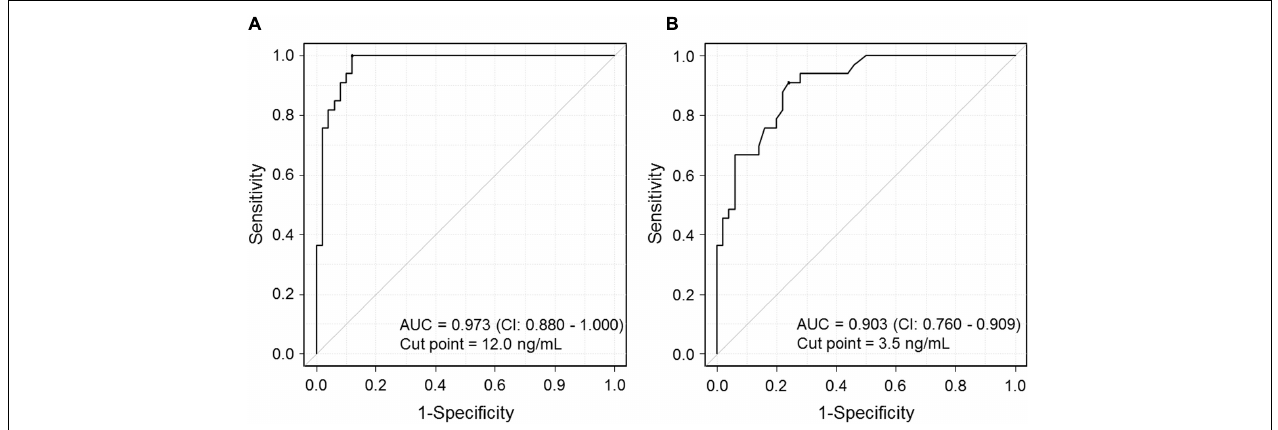
FIGURE 4 | Graph showing the receiver operating characteristic (ROC) curve for predicting the risk of CSC development. (A) The ROC curve shows the relationship between serum mtDNA levels and the occurrence of CSC. Area under the ROC curve (AUC): 0.973. CSC, central serous chorioretinopathy. (B) The ROC curve shows the relationship between serum HMGB1 levels and the occurrence of CSC. AUC: 0.903. CSC, central serous chorioretinopathy; HMGB1, high-mobility group box (HMGB) 1. TABLE 3 | Univariate and multivariate regression analysis of the association between serum mtDNA levels and clinical parameters in patients with treatment-naïve acute CSC. Variable Univariable linear regression Multivariable linear regression * Regression Coefficient R 2 P -value Regression Coefficient P